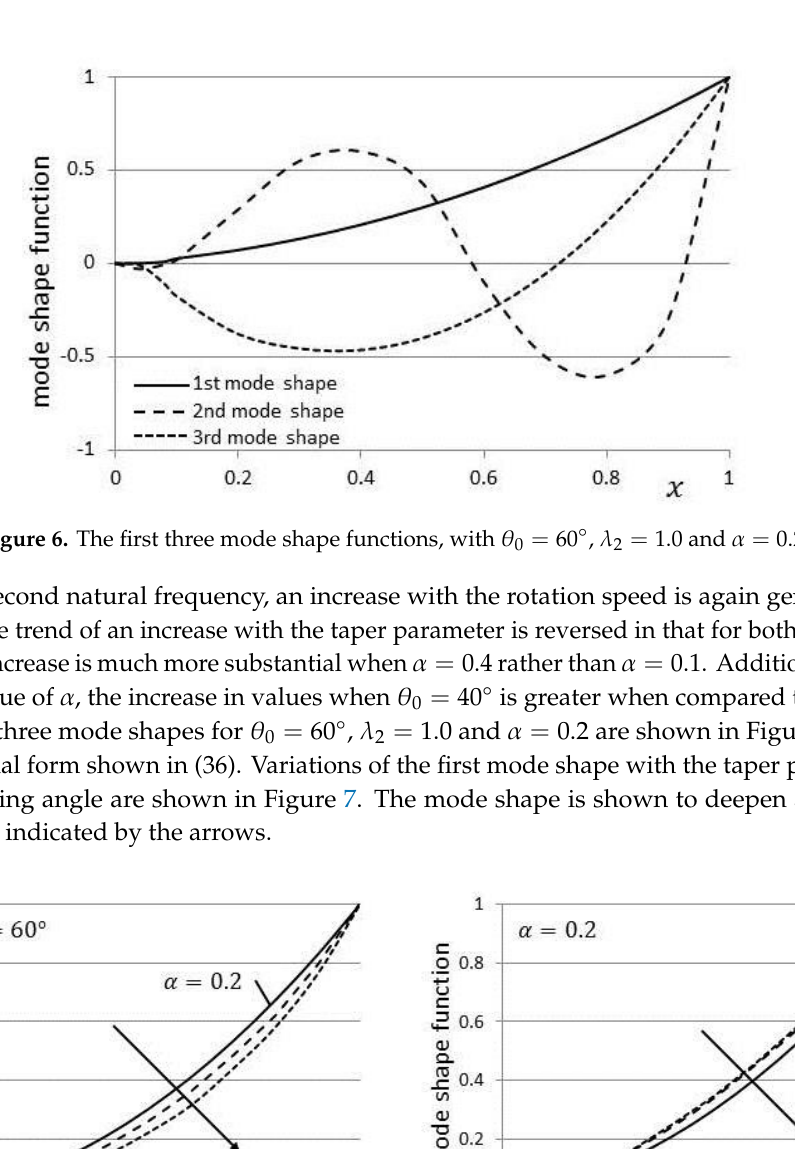
Figure 8. Effect of the hub radius parameter on the first frequency. In this investigation, the accuracy of the present method is examined using the absolute error remainder functions and the maximal error remainder parameters, as defined for the current model (see (15)):